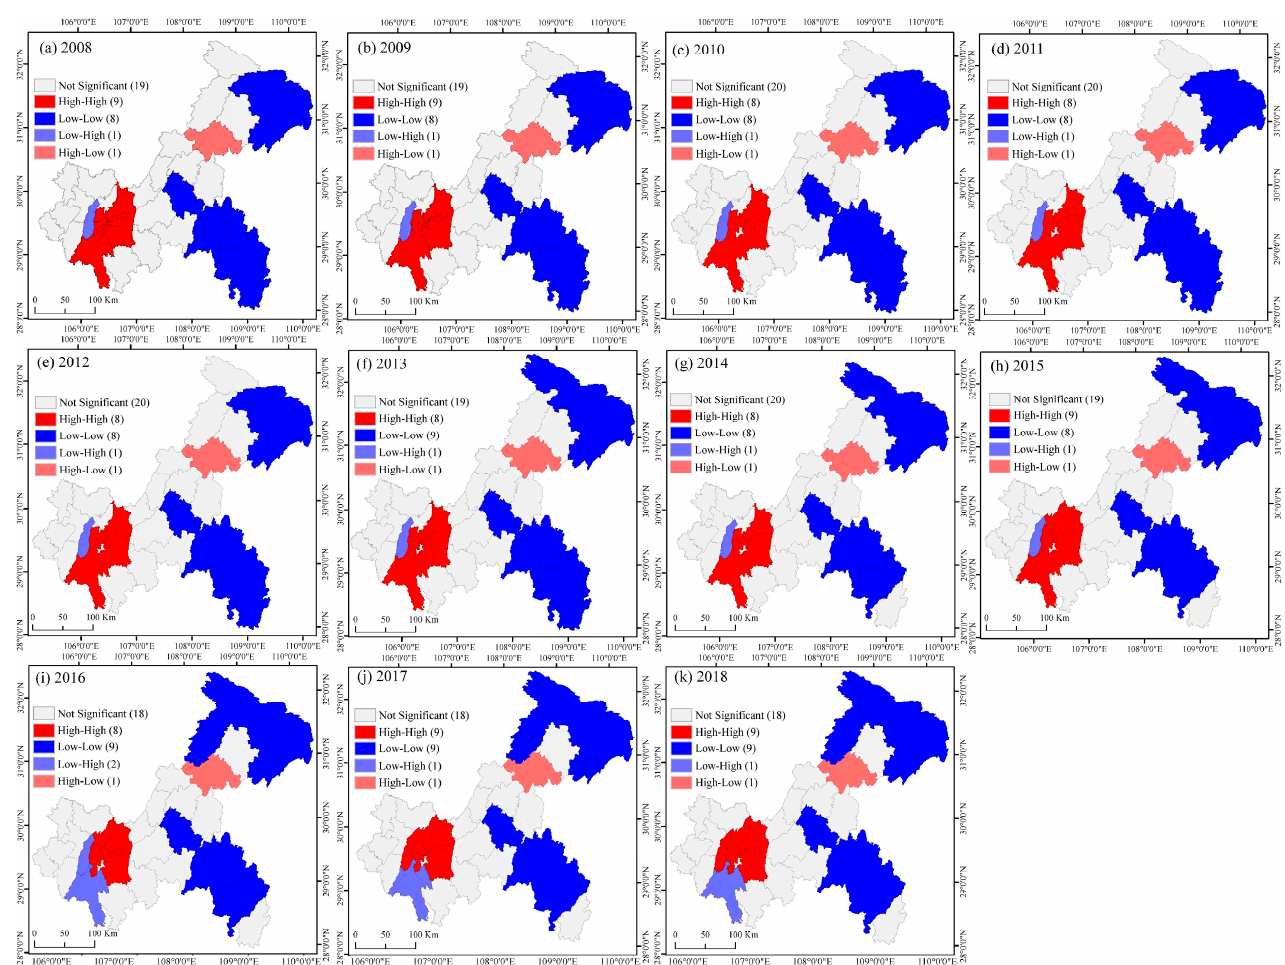
Figure 12. The local spatial autocorrelation of the PU. ( a – k ) LISA diagram of PU in Chongqing during